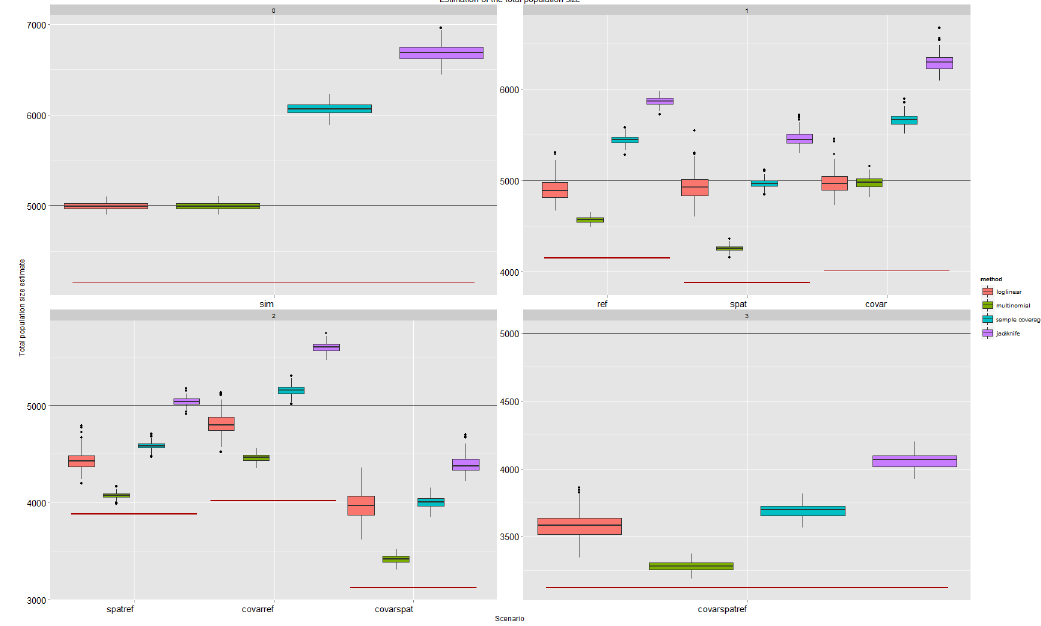
Fig 3. Boxplots of the obtained estimates per scenario and method. The models were chosen without assumptions on the underlying dependency structure. The black line indicates the total population size, the red line indicates the number of unique cases per